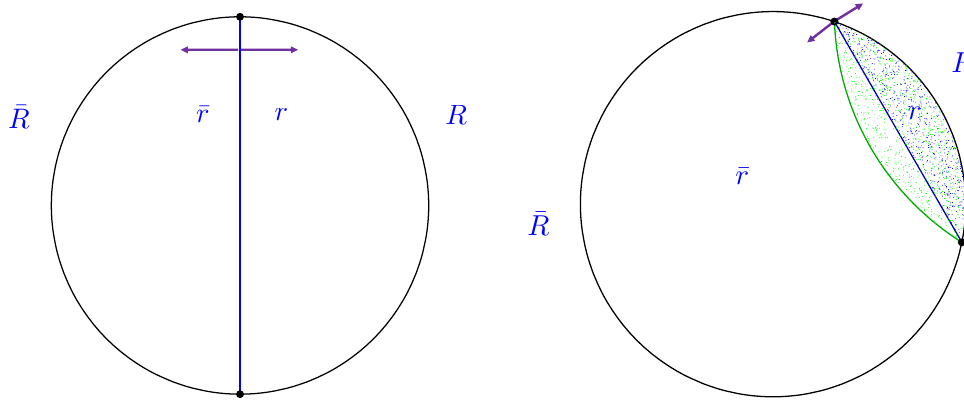
Figure 3 . A schematic illustration of the relationships between the regions described in the text, on a timeslice which we can take for simplicity to be at the moment of time symmetry in the gravity- side geometry. We show both the Z 2 symmetric case where the interval R and its complement (cid:22) R are of the same size (left panel) and the case where they are unequal (right panel). The Ryu- Takayanagi surface is indicated in blue, and it separates the bulk e(cid:11)ective (cid:12)eld theory subregion r from its complement (cid:22) r . The causal wedge of the smaller subregion is indicated in light green in the asymmetric case, indicating that it exceeds the entanglement wedge (indicated by blue hatchmarks). This leads to the intersection between the CW of the smaller subregion and the EW of the complementary region discussed in the text. The purple arrows indicate the action of the bulk modular Hamiltonian [5] on probe bulk (cid:12)elds near the RT surface near the boundary, projected to the pictured spatial slice. In the left picture, similarly to asymptotically AdS spacetime, the RT surface intersects the boundary orthogonally, while generically in the deformed theories this is not the case, and the modular evolution in the bulk has a component that is orthogonal to the